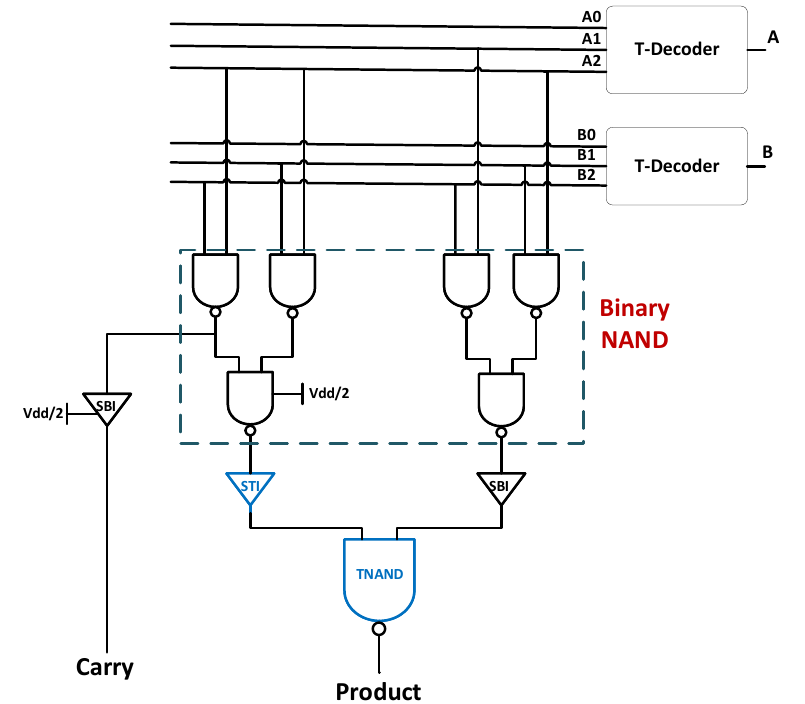
Figure 2. Single-trit multiplier implementation.